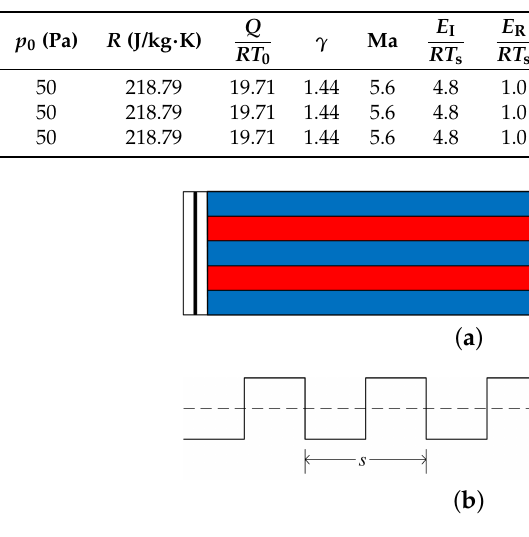
Figure 2. Schematic of the computation setup, ( a ) top view and ( b ) side view.